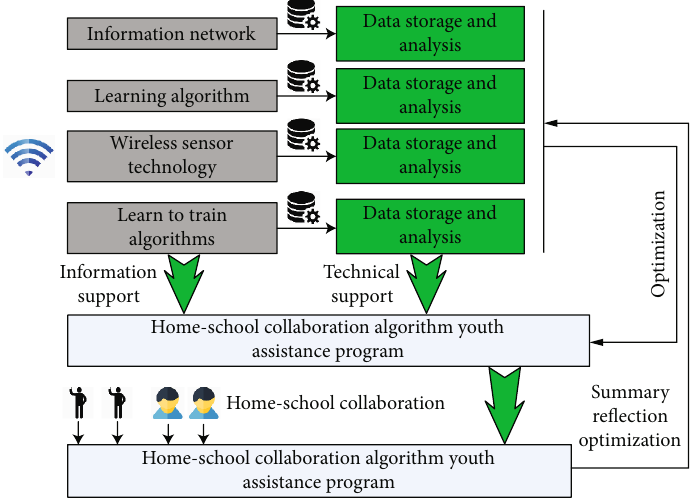
Figure 4: Technical framework of re fl ection and summary based on network information